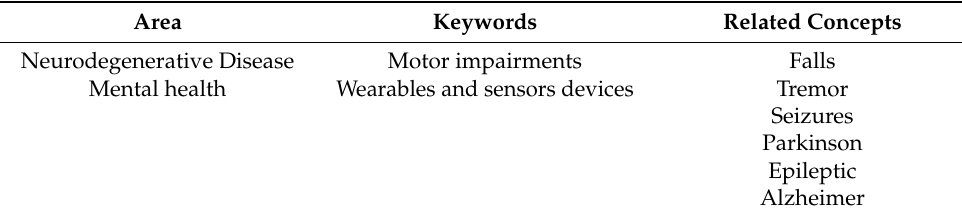
Table 2. Keywords and related concepts used in this literature